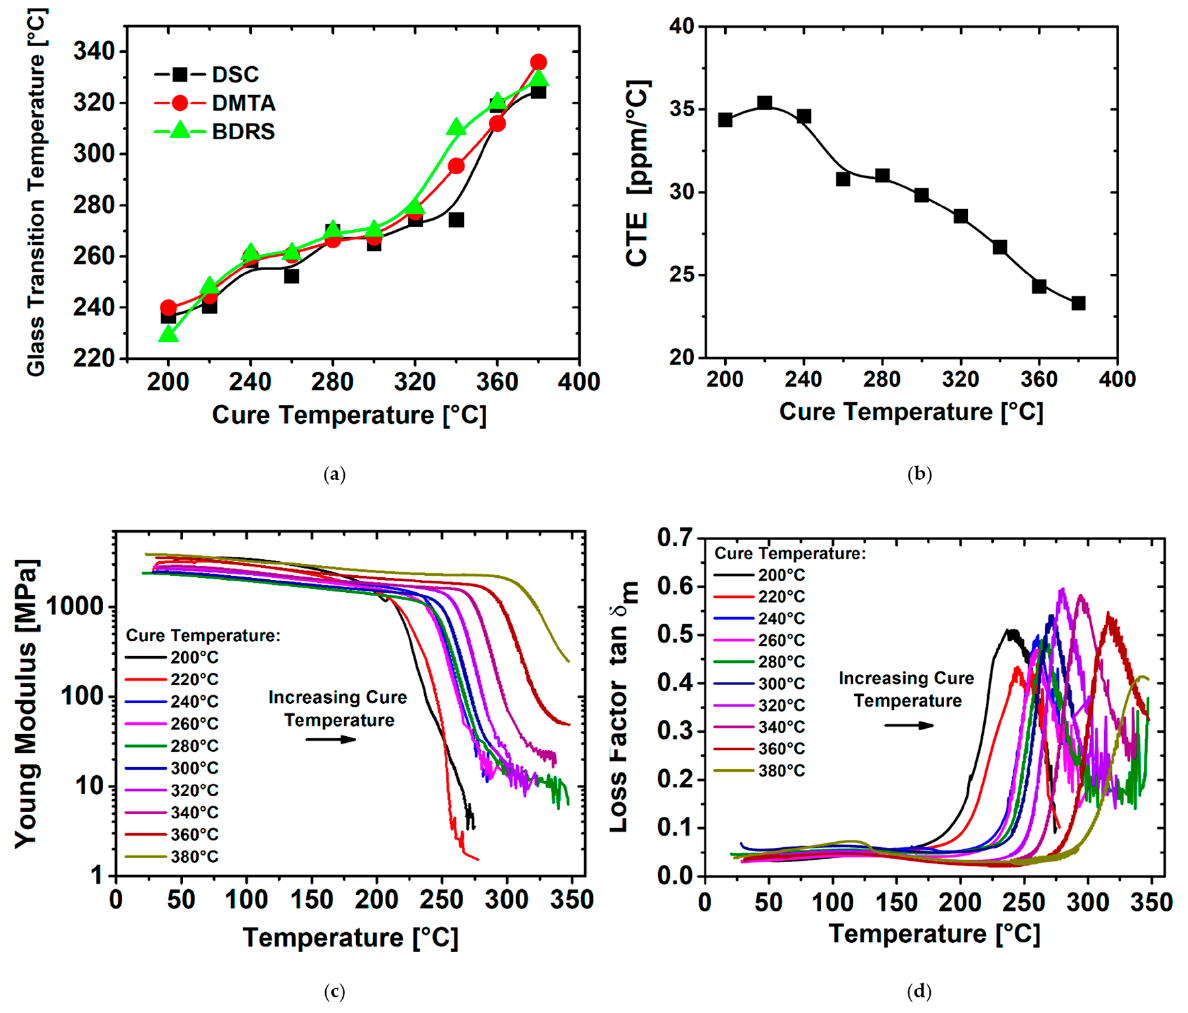
Figure 4. ( a ) Comparison between T g obtained from DSC, DMTA (1 Hz) and BDRS (1 kHz). ( b ) CTE versus the cure temperature. ( c ) Mechanical storage modulus and ( d ) mechanical loss factor as a function of the measurement temperature and for the different cured films.